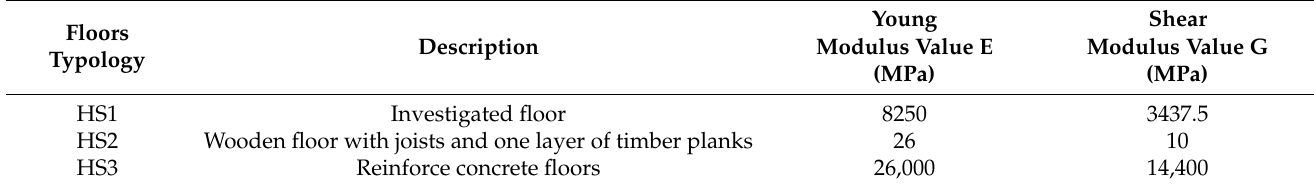
Table 5. Mechanical characteristics of floor typologies.